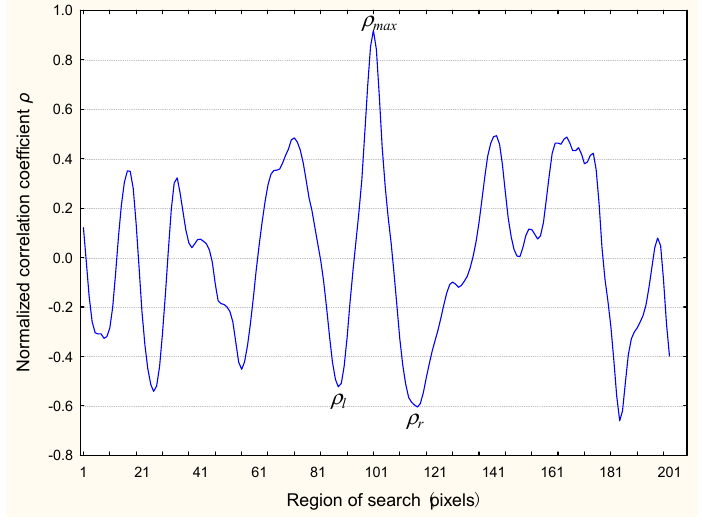
Figure 2. CC Curve.